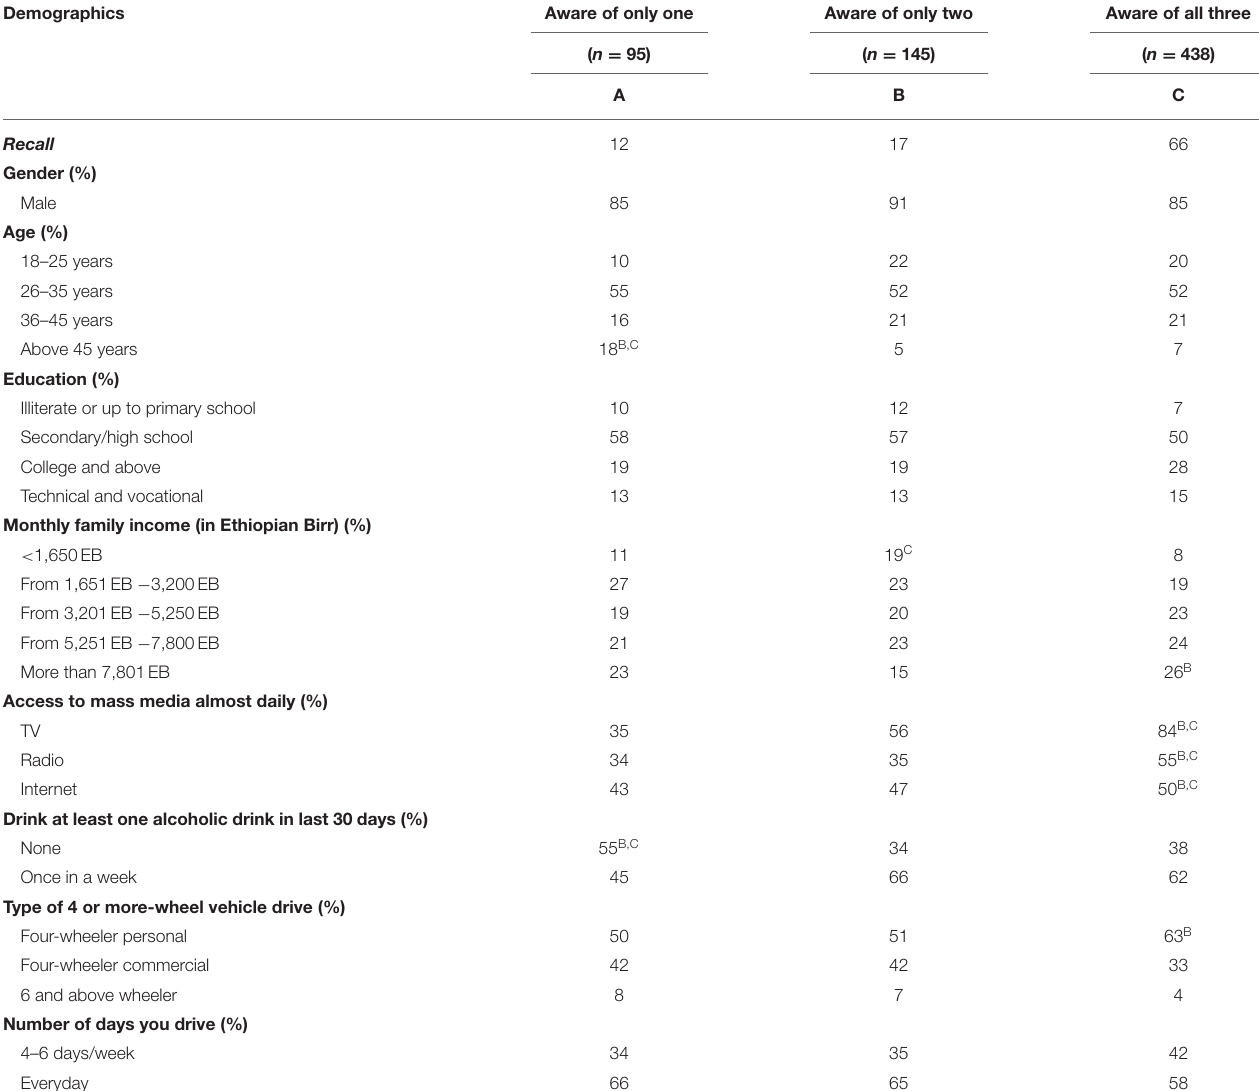
TABLE 2 | Demographic characteristics of participants by number of PSAs recalled. Demographics Aware of only one Aware of only two Aware of all